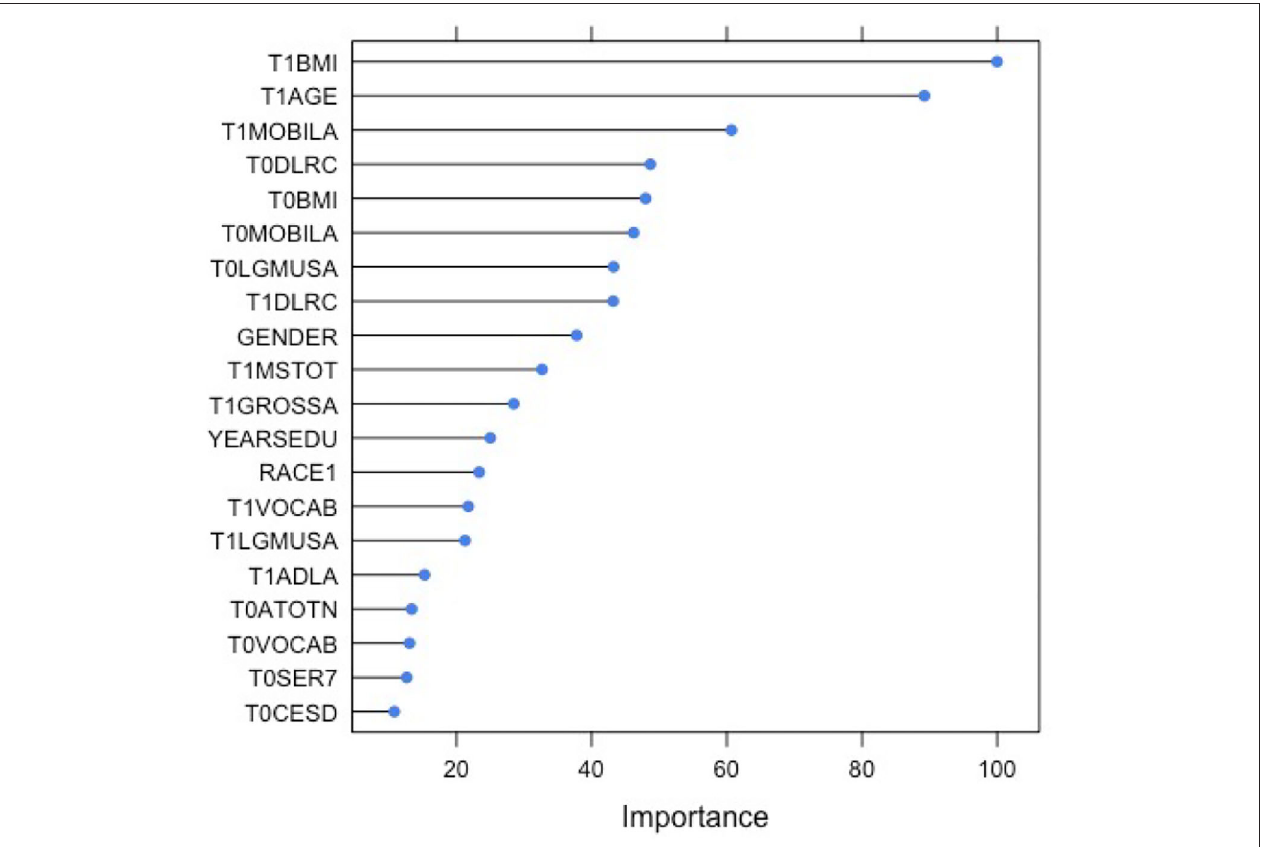
FIGURE 3 | The plot of 20 most influential variables in predicting post-stroke mortality (T3_DefAlive). T0 in the variable name means the corresponding variable before the stroke. T1 in the variable name means the corresponding variable immediately after the onset of stroke. BMI, Body Mass Index; MOBILA, MOBILity; LGMUSA, LarGe MUScle; DLRC, DeLayed word ReCall; MSTOT, TOTal Mental Status summary score; GROSSA, GROSS motor skills; YEARSEDU, YEARS of EDUcation; VOCAB, VOCABulary score; ATOTN, TOTal Non-house Assets; SER7, SERial 7s test; CESD, The Center for Epidemiologic Studies Depression scale. Refer to for the meanings of variables in